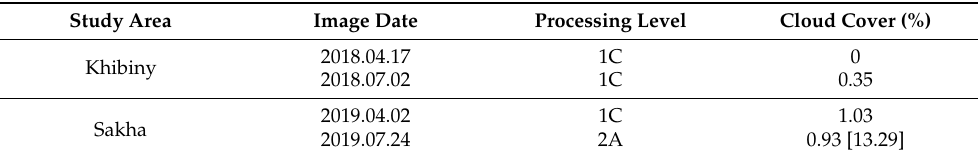
Table 1. Sentinel-2 MSI images processed in this study. Cloud cover for each image is the arithmetic mean of the cloud cover reported in image metadata for all tiles contributing to the image. The figure in brackets [] is the percentage image area actually masked out, including smoke contamination.